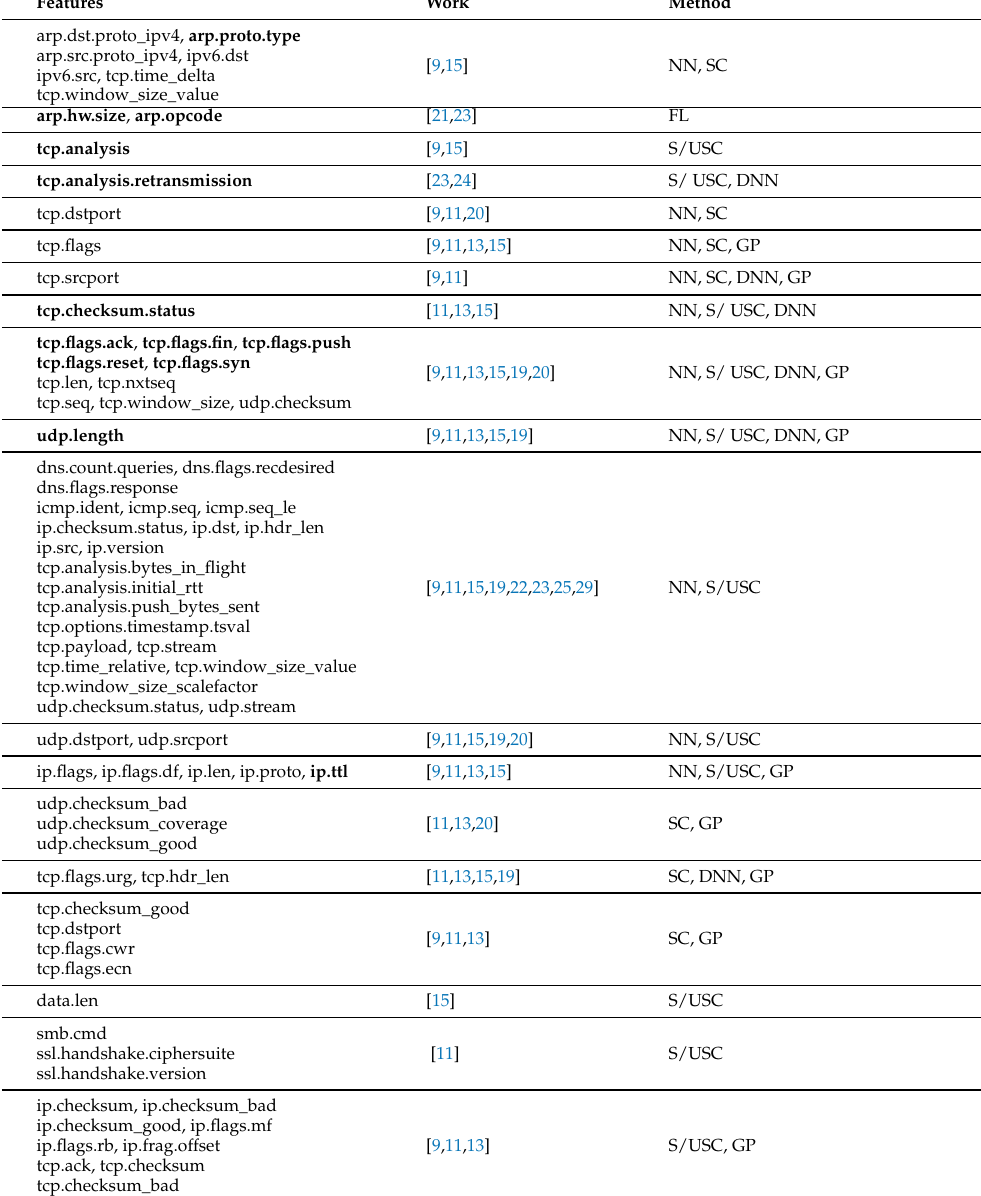
Table 1. Set of features referenced in the related work. The rightmost column denotes the chosen ML methodology that was applied per feature set: Supervised/Unsupervised Swallow Classification (S/USC), Swallow Classification (SC), Genetic Programming (GP), Neural Networks (NN), Deep Neural Networks (DNN). The features in bold were also used in the context of this work, as explained further down in Section